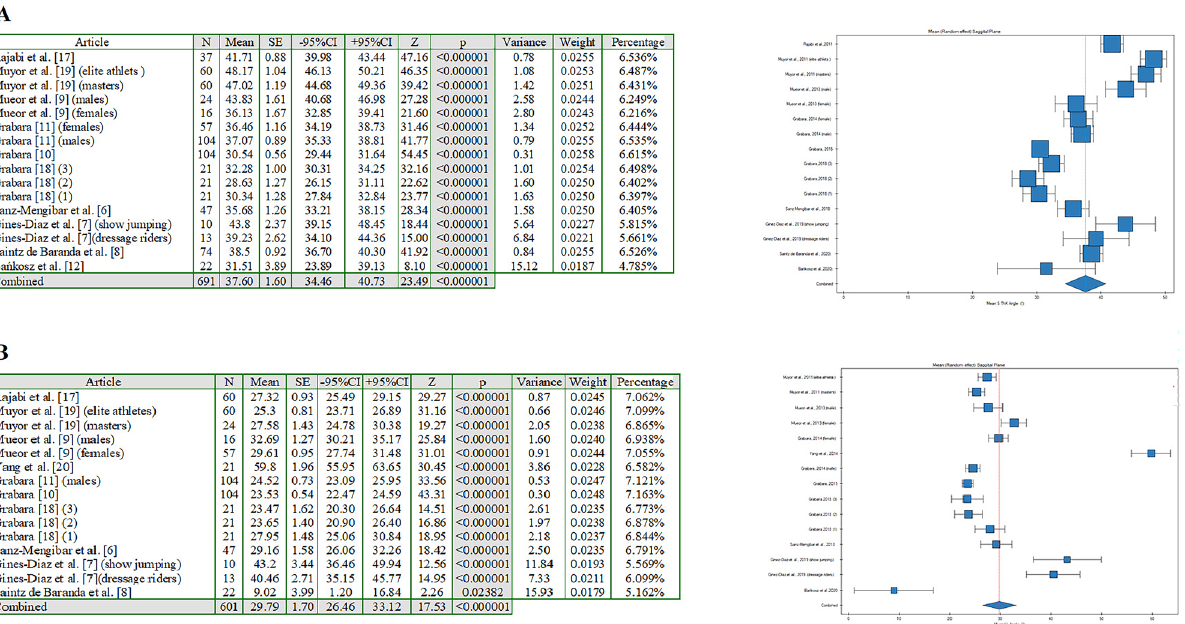
Figure 3. Forest plot (random-effects model) showing mean ( A ) ThK Angle (°), ( B ) LL Angle(°) in the sagittal plane for each of oncluded studies and the pooled data for all studies (created with: PQStat software (version PQStat V